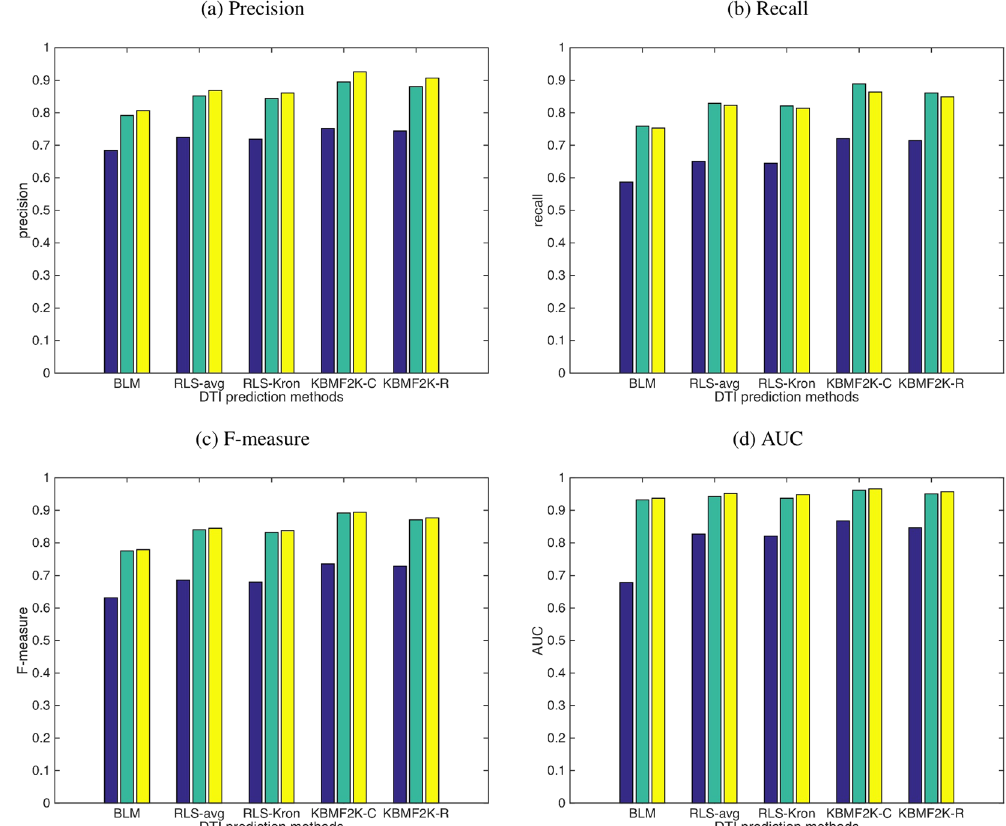
Figure 6. Performance comparison of different negative sample selection methods. Blue denotes the performances of random selection method, green denotes the performances of NCPIS and yellow denotes the performances of our proposed NDTISE method. ( a – d ) Represent precision, recall, F-measure and AUC values of different negative samples extraction methods using respective classification models, respectively.